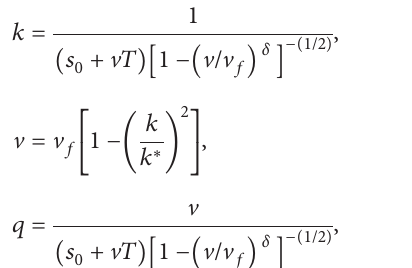
the same figure with the premeditated parameter values